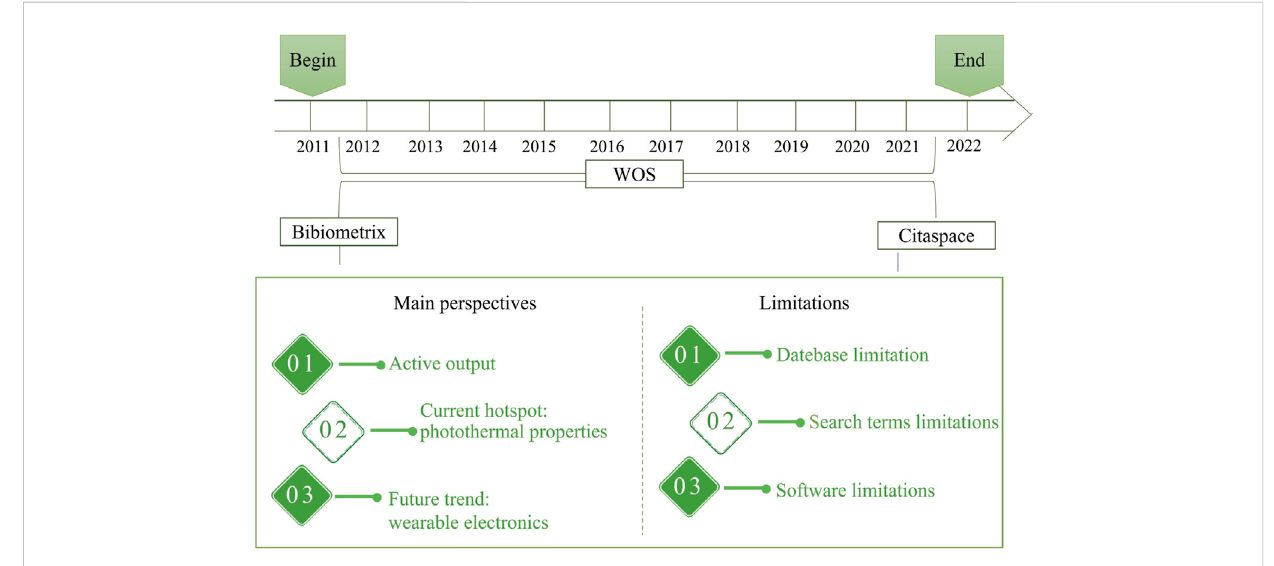
FIGURE 7 Main perspectives and limitations of the